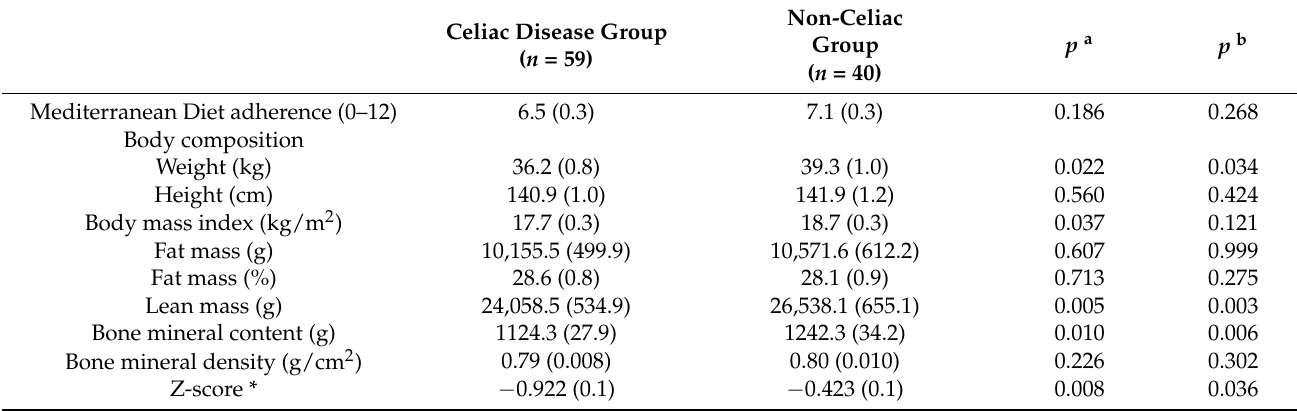
Table 2. Differences in Mediterranean Diet adherence, body composition, and some serum bone-related markers between groups (celiac disease versus non-celiac group).